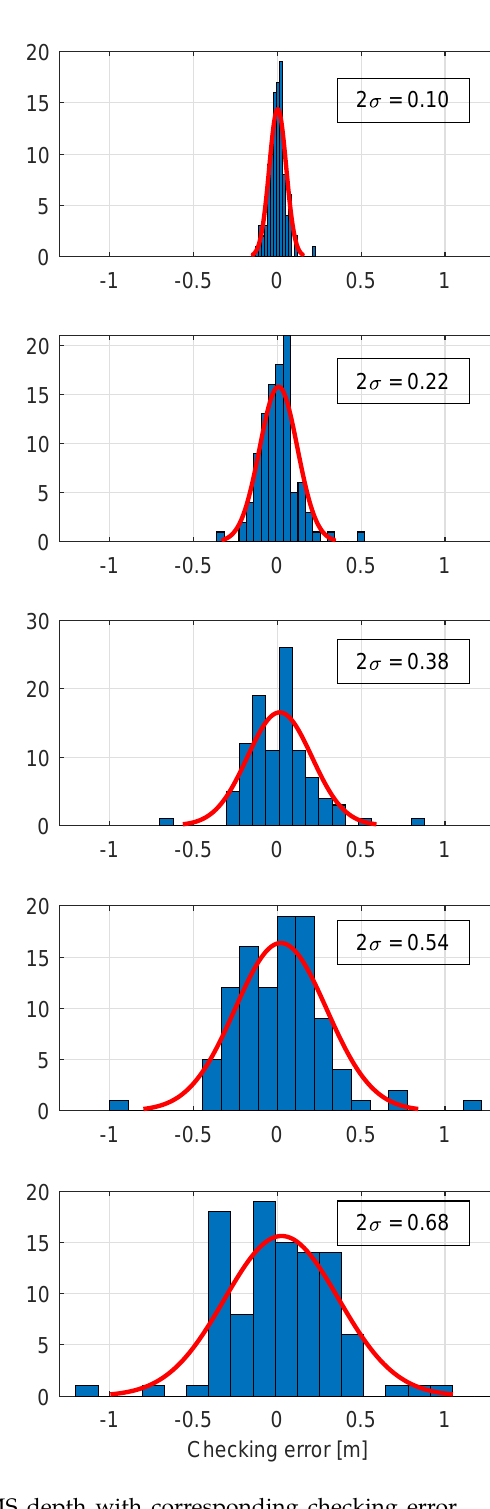
Figure 8. The error between predicted and real TMS depth with corresponding checking error distributions. ( a ) The TMS depth prediction 1 s in future; ( b ) The TMS depth prediction 1.5 s in future; ( c ) The TMS depth prediction 2 s in future; ( d ) The TMS depth prediction 2.5 s in future; ( e ) The TMS depth prediction 3 s in